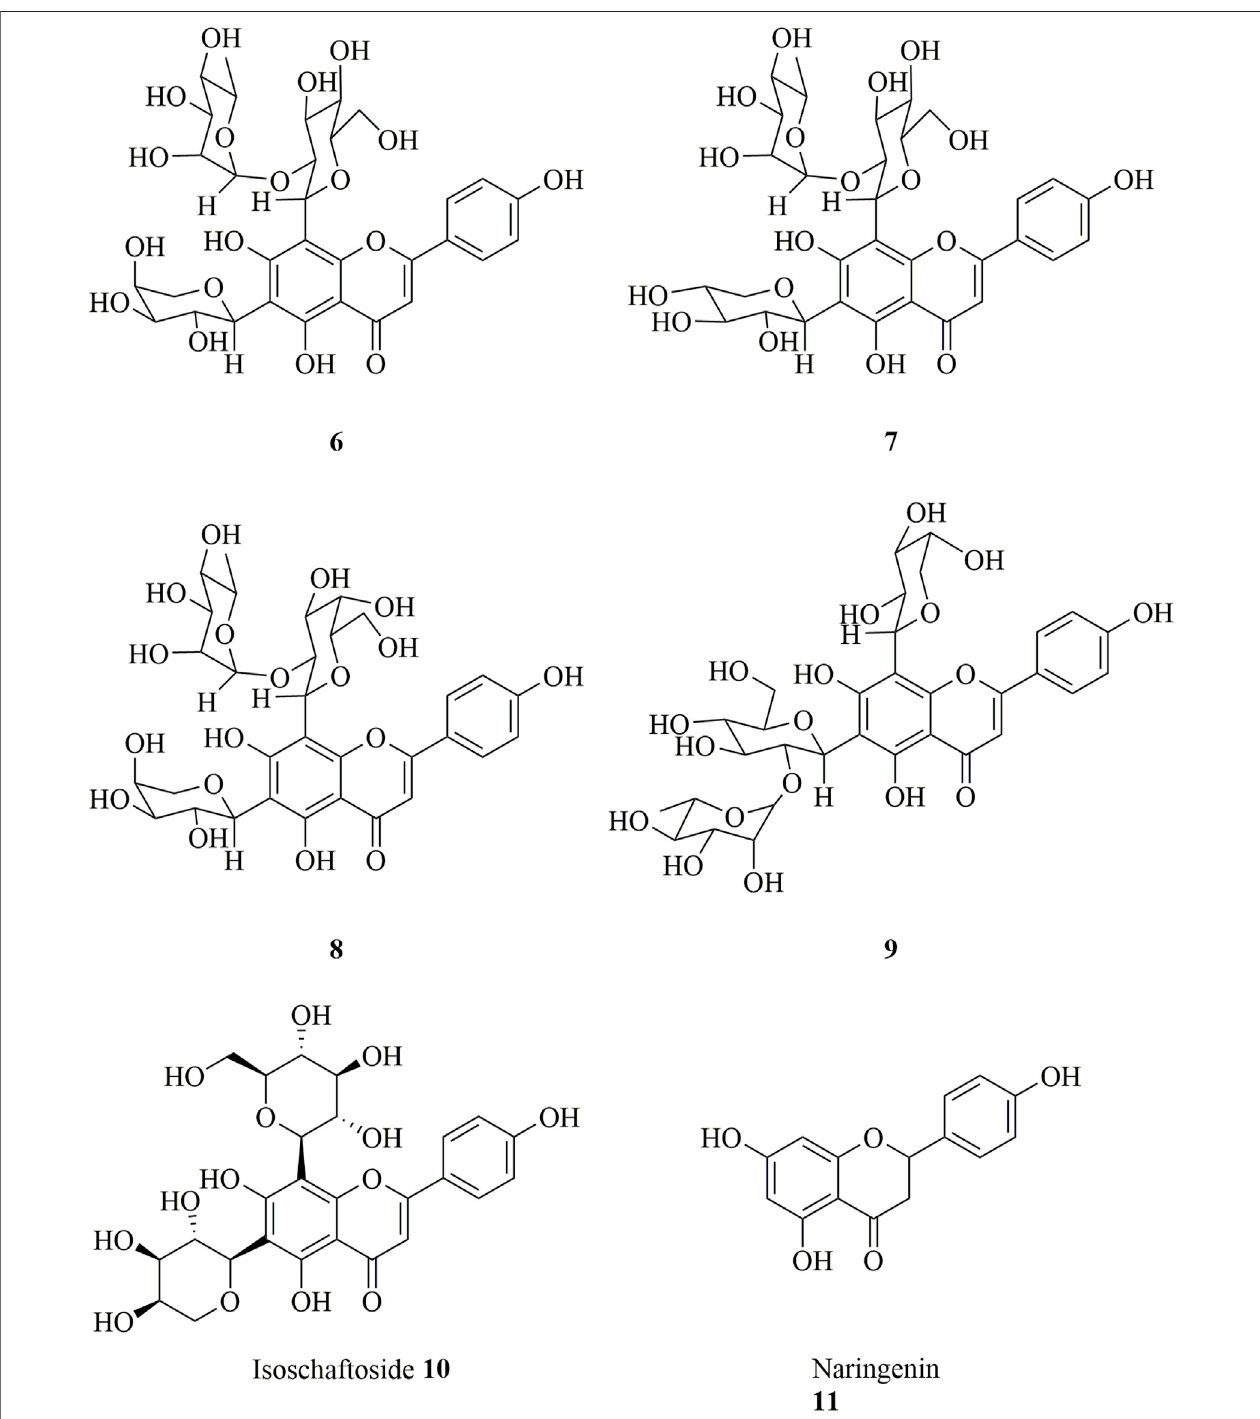
FIGURE 4 | Structure of fl avonoids ( 6 – 11 ) in D. huoshanense